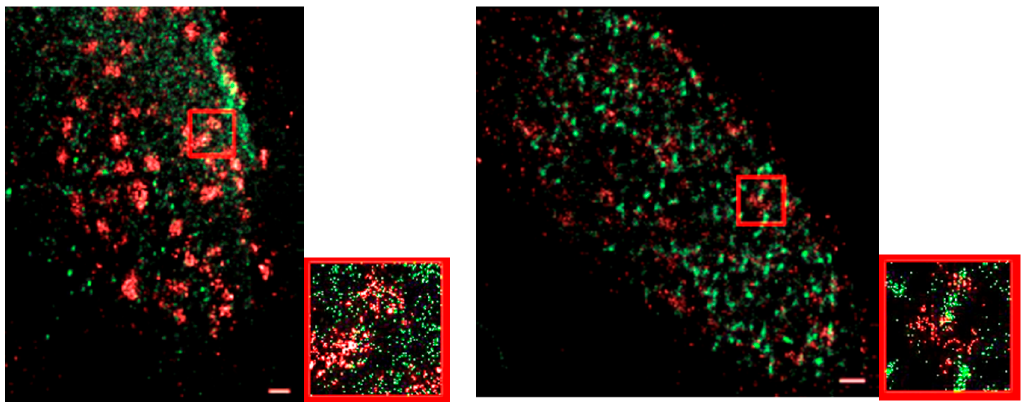
Figure 8. Two color SMLM images of two MCF-7 cell nuclei after irradiation. Left images show the situation 30 min post irradiation; right images 180 min post irradiation. While γ -H2AX (red labelling) has already formed foci after 30 min, MRE11 (green labelling) is still more dispersed. After 180 min, both signals show strong clustering (foci formation). The small images are enlarged sections of the larger images (red rectangle).